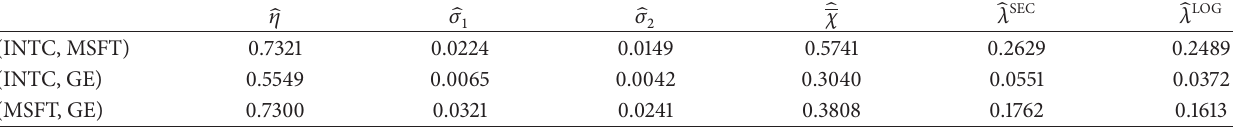
̂𝜆 LOG ̂𝜒, ̂𝜆 SEC and , for (INTC, MSFT), (INTC, GE), and (MSFT, GE), with 𝑏 = 0.005